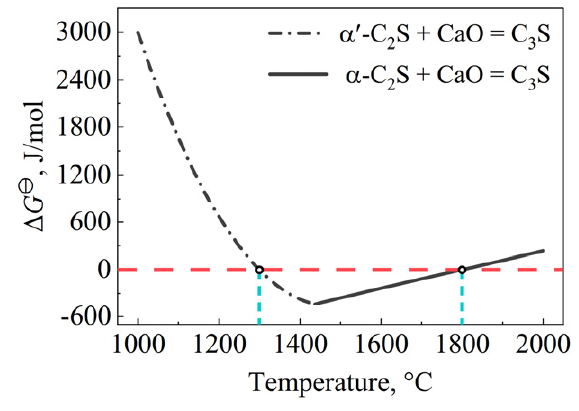
Figure 9. The curve generated by C 3 S.